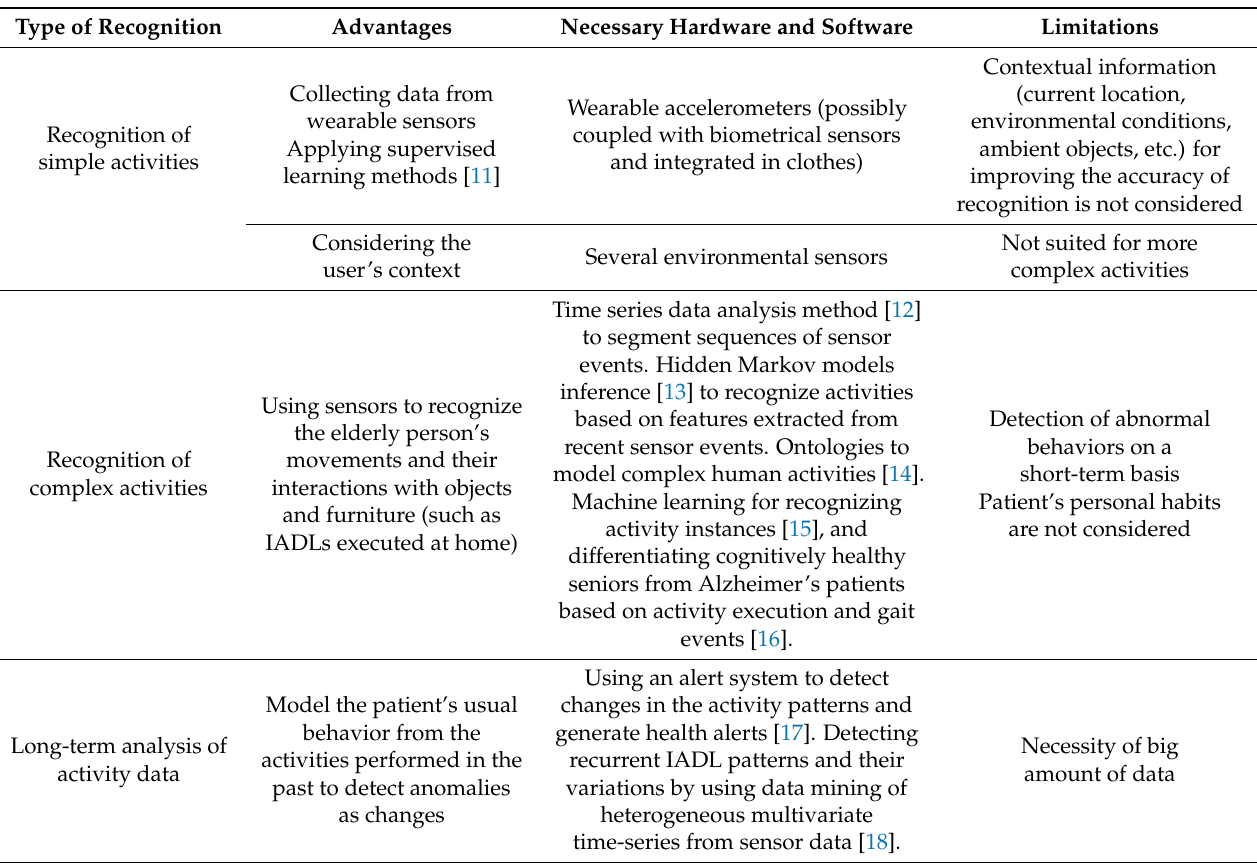
Table 1. Activity recognition methods